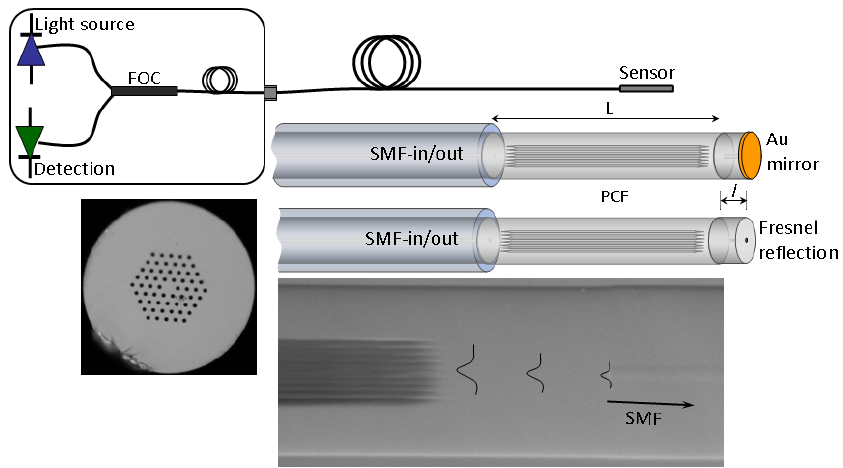
Figure 1. Drawings of our interferometer showing two possible terminations and schematic representation of the interrogation set up. FOC stands fiber optic circulator; SMF for single mode fiber, L for PCF length, and l is the length of SMF at the distal end. The micrographs show the PCF cross section and details of the PCF-SMF junction. The broadening of the beam when it enters the collapsed region is